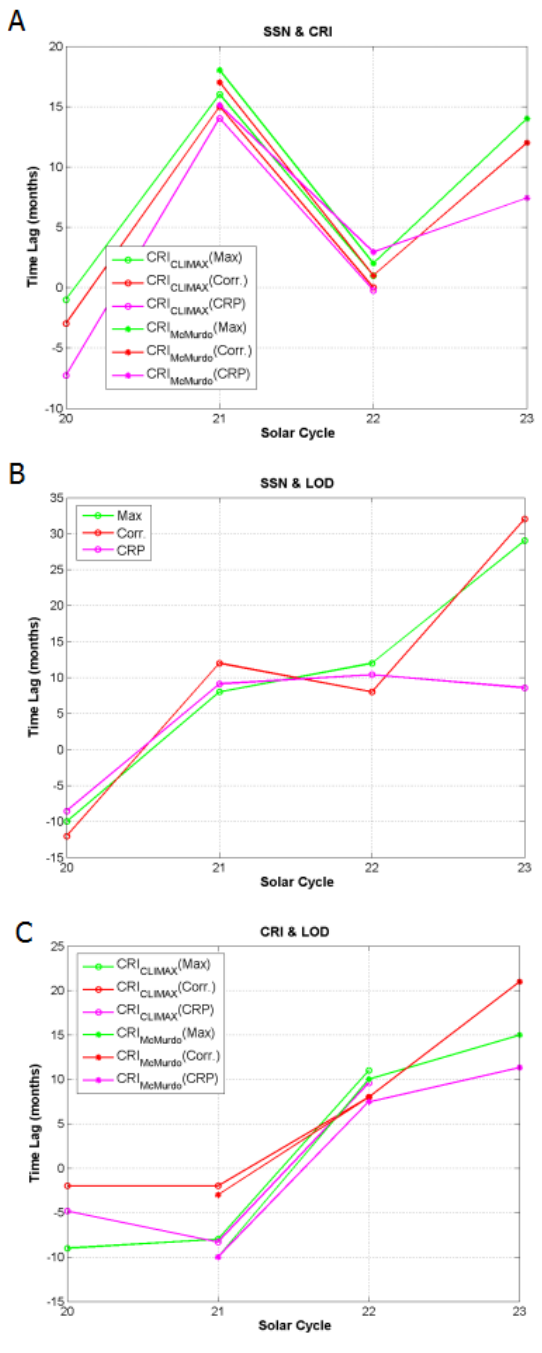
Figure 6. Time lags (in months) between normalized data sets pre- sented in Fig. 4 calculated using different methods for (A) SSN and CRI Inv , (B) SSN and LOD Inv and (C) CRI Inv and LOD Inv . Solar cycles are from 20 to 23. The limits of the cycles are considered as minima of curves. For each pair, positive lag means that the first parameter is ahead of the second one, and negative is the